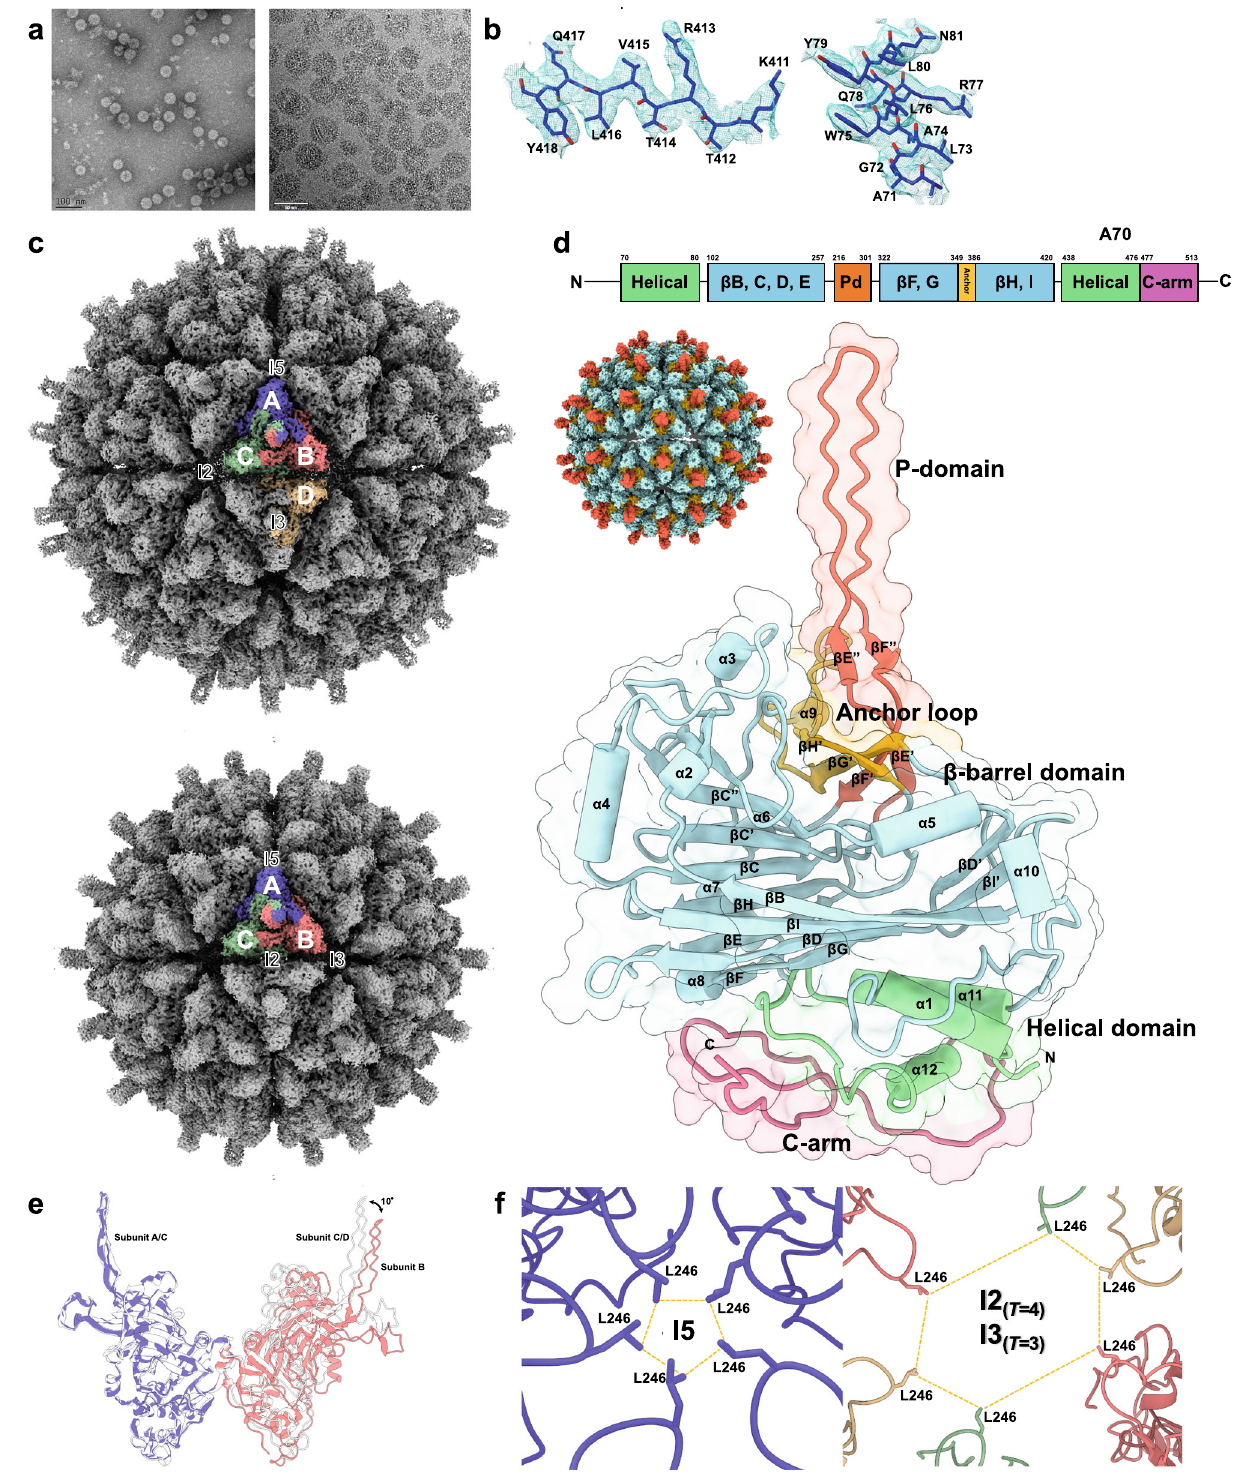
Fig. 1 | Characterization of LSV2 VLP assembly and the CP structure. a The representednegative-stained(left)andcryo-micrograph(right)showsLSV2CPself- assembly in vitro. 20 independent micrographs (left) and 11,245 micrographs (right)gavesimilarresults.Scalebars:100(left)and50nm(right). b Representative cryo-EM electron densities of several amino acids and the fi tted atomic models. c The overall cryo-EM densities and structures of T =4 (upper) and T =3 (lower) LSV2 VLPs containing one icosahedral asymmetry unit colored in purple (subunit A), red (subunit B), green (subunit C), and yellow (subunit D, upper), respectively.